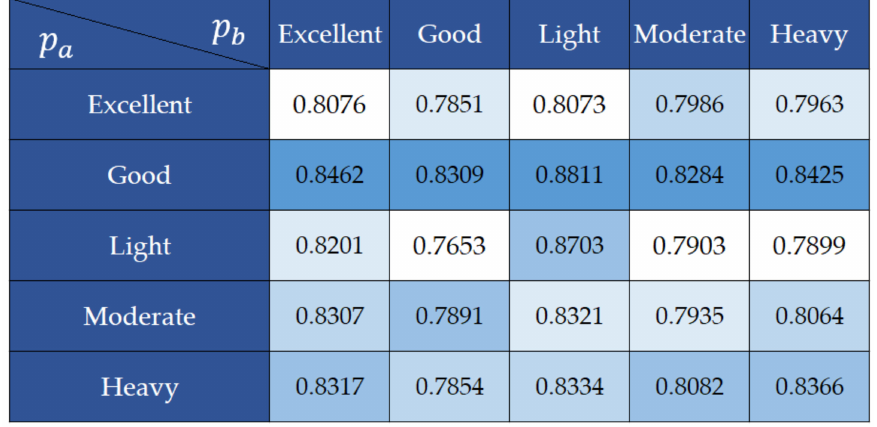
Figure 14. Color similarity between reference images and matching